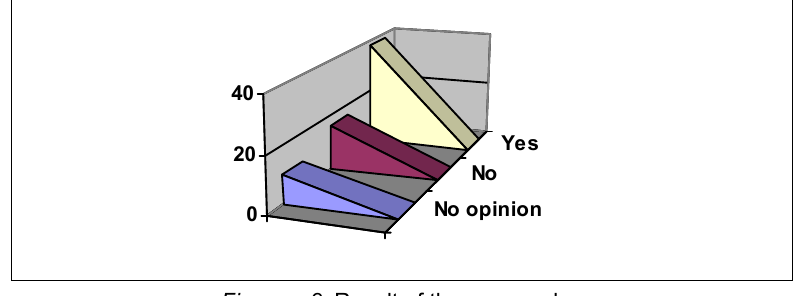
Figure – 8 Result of the mean value Рис . 8 – Результаты среднего значения Слика 8 – Резултат средње